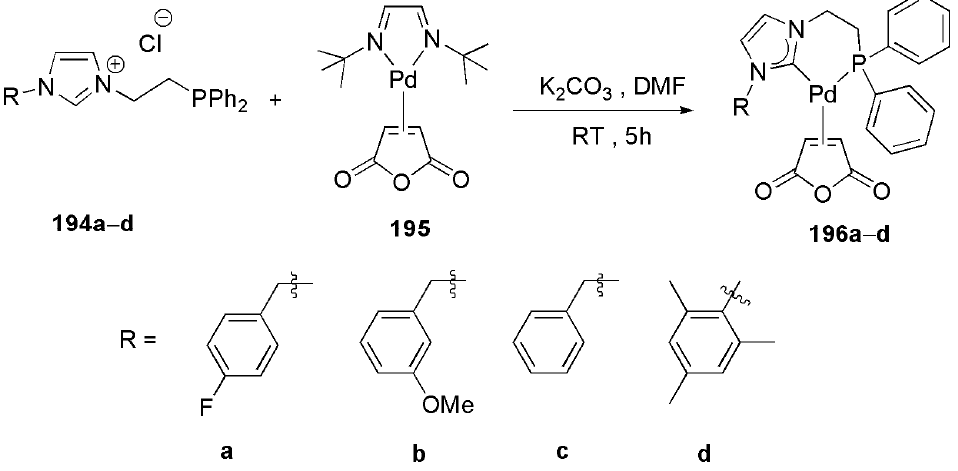
Figure 23. A bis ‐ NHC palladium complex supported on nanomagnetic particles [192]. A bidentate NHC-PPh 2 ligand has been utilized for the preparation of palladium(0) complexes to be used in Heck reactions [193]. The imidazolium salts 194 were prepared starting from N-substituted imidazoles which were first heated at 90 ◦ C for 24 h in 1,2- then transformed into 194 by reaction with KPPh 2 [193]. Reaction of deprotonated 194 with the palladium(0) precursor 195 in DMF yielded the desired Pd(0)-NHC-PR 2 complexes 196 (Scheme